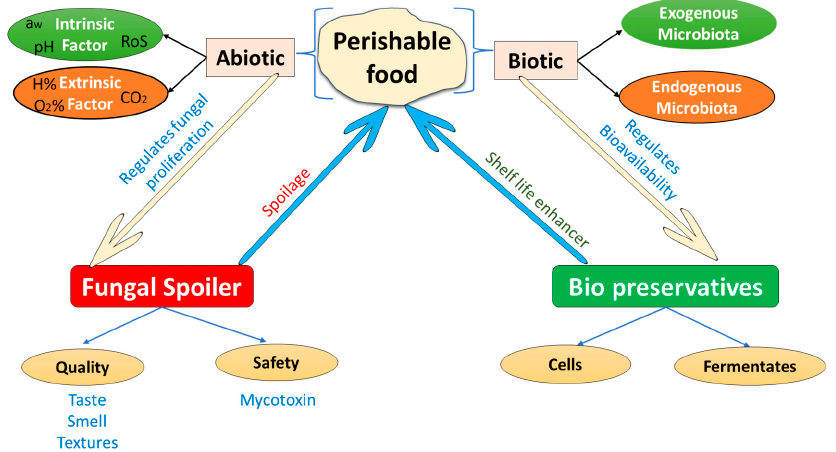
Figure 1. Schematic representation of perishable food ecosystem and their interaction between food spoilers and bio-preservatives.